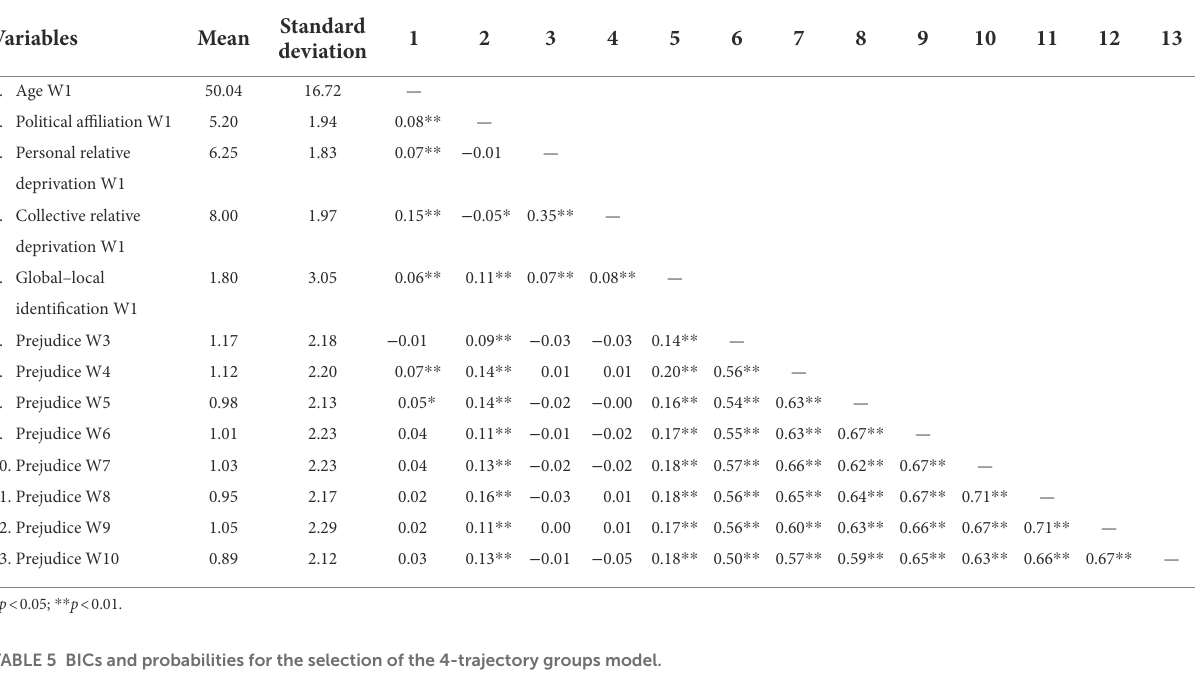
TABLE 5 BICs and probabilities for the selection of the 4-trajectory groups model.